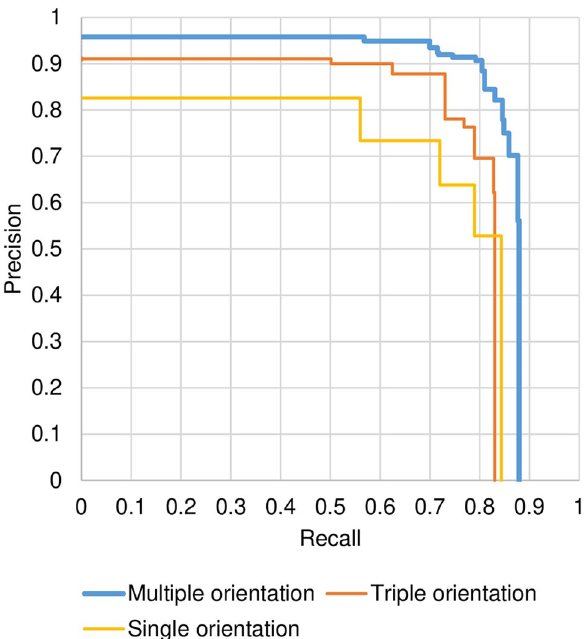
Figure 3. Precision-recall